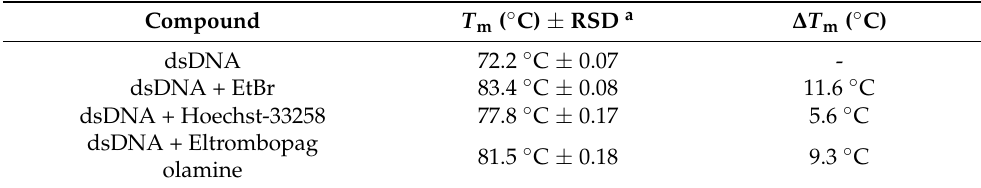
Table 2. Thermal denaturation values ( ◦ C) of dsDNA in the absence and in the presence of EtBr, Hoechst-33258, and